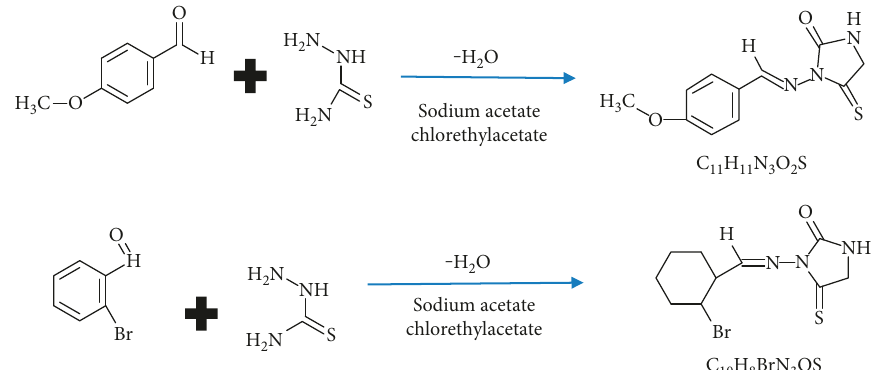
Figure 1: Synthetic diagram of new compounds (C5 and C6) [25].